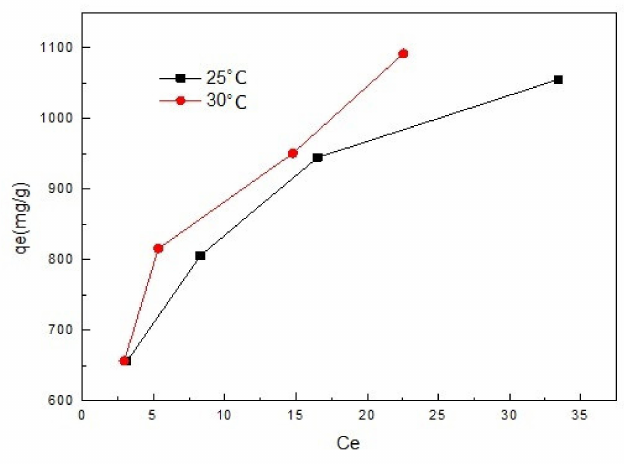
Figure 11. Equilibrium adsorption at different